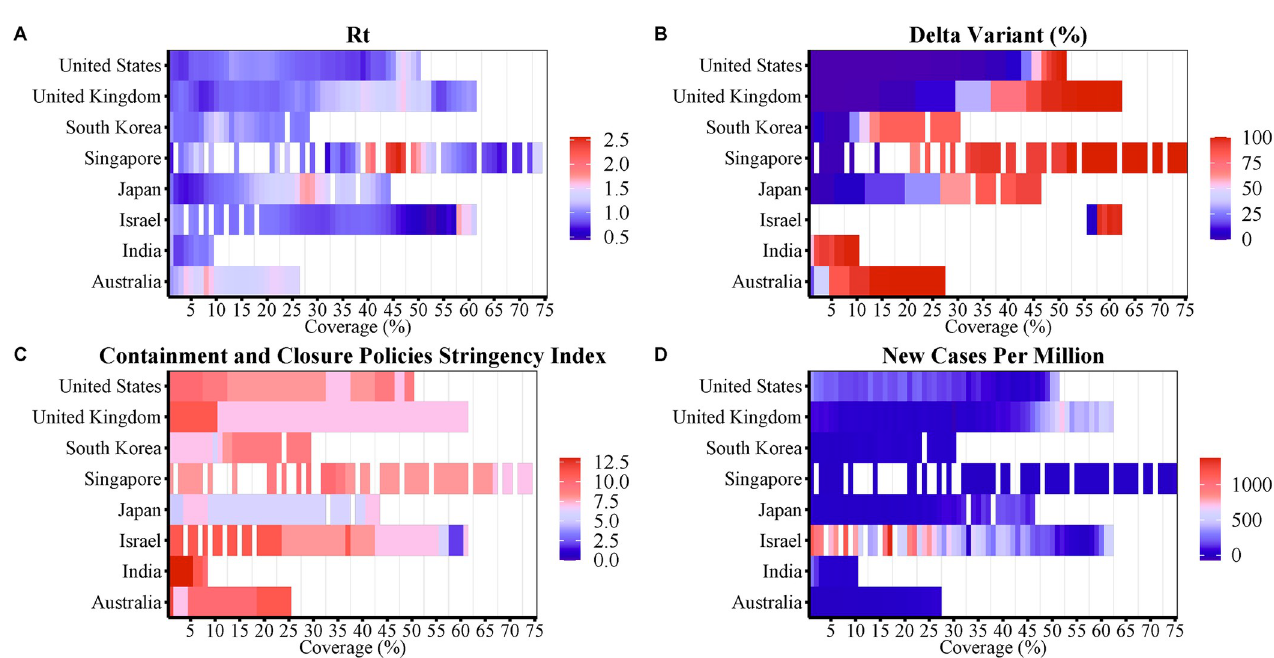
Fig 3. Association of vaccine coverage with R t (A), new cases per million (B), containment and closure policies stringency index (C) and Delta variant proportion (D) in eight different countries.